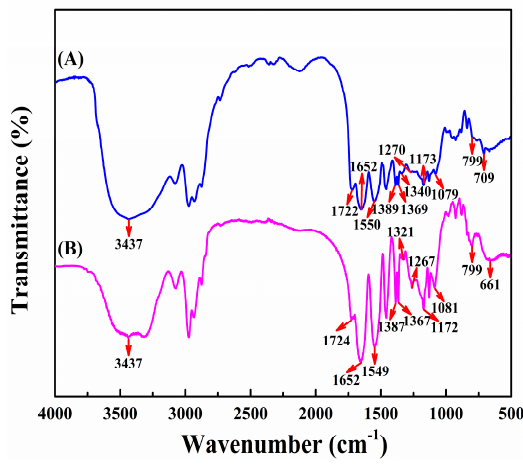
Figure 2. FT-IR spectra of PNAHT ( A ) and PNHT ( B ) copolymers.